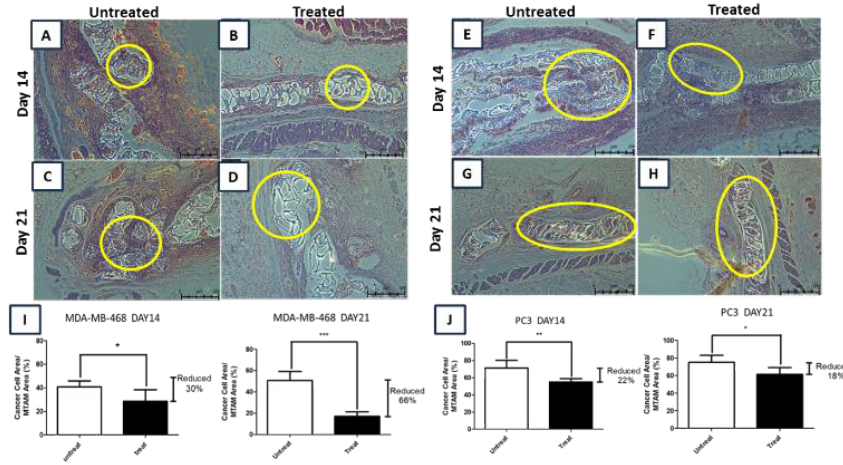
Figure 5. Day 14 and 21 of H&E staining images of MDA-MB-468 ( A – D ) and PC 3 ( E – H ); and the corresponding viabilities ( I and J ). When compared to control, a reduction in total cell area reduction of 30% (MDA-MB-468) and 21% (PC 3) were registered on day 14; and by day 21, the reduction increased to 68% (MDA-MB-468), while the reduction reduced to 18% (PC 3). In the case of MDA-MB-468 that was treated with hybridoma cell culture supernatant extract, almost no cells were observable by day 21 ( D ). In contrast, a large quantity of cells was still observable in PC 3 ( H ).